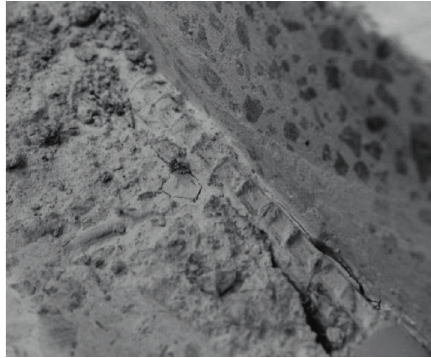
Figure 5: Steel-concrete interface for the OPC beam.